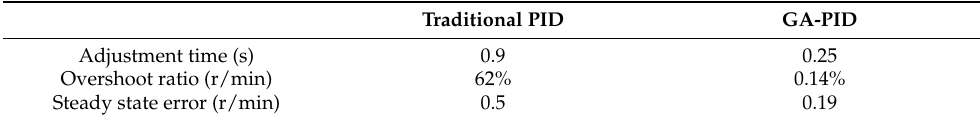
Table 3. Simulation data of rotation speed under the single coal hardness.